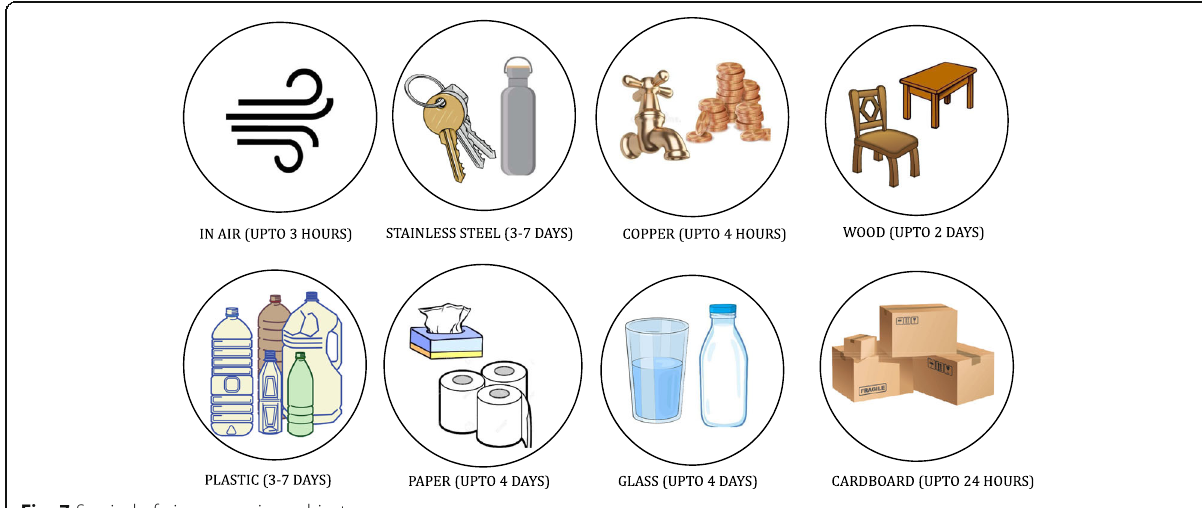
Fig. 7 Survival of virus on various